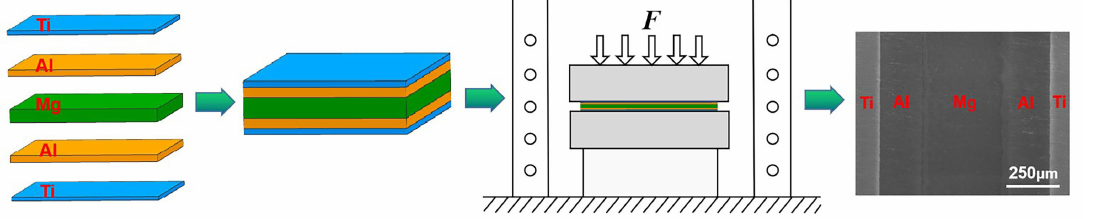
Figure 2. The schematic diagrams of fabricating Ti/Al/Mg/Al/Ti laminated